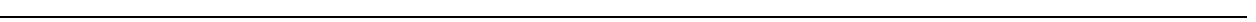
Fig. 2 SRSF5 controls CCAR1 splicing to regulate tumor cell growth. a Schematic diagram of CCAR1 splice variants. b In vivo ultraviolet cross-linking and immunoprecipitation (CLIP) from cells transfected with indicated plasmids were subjected to qPCR analysis with speci fi c primers (left panel). Expression of each protein was con fi rmed by immunoblotting (right panel). c Depletion of SRSF5 leads to a shift of CCAR1 splicing module in A549 and H358 cells.